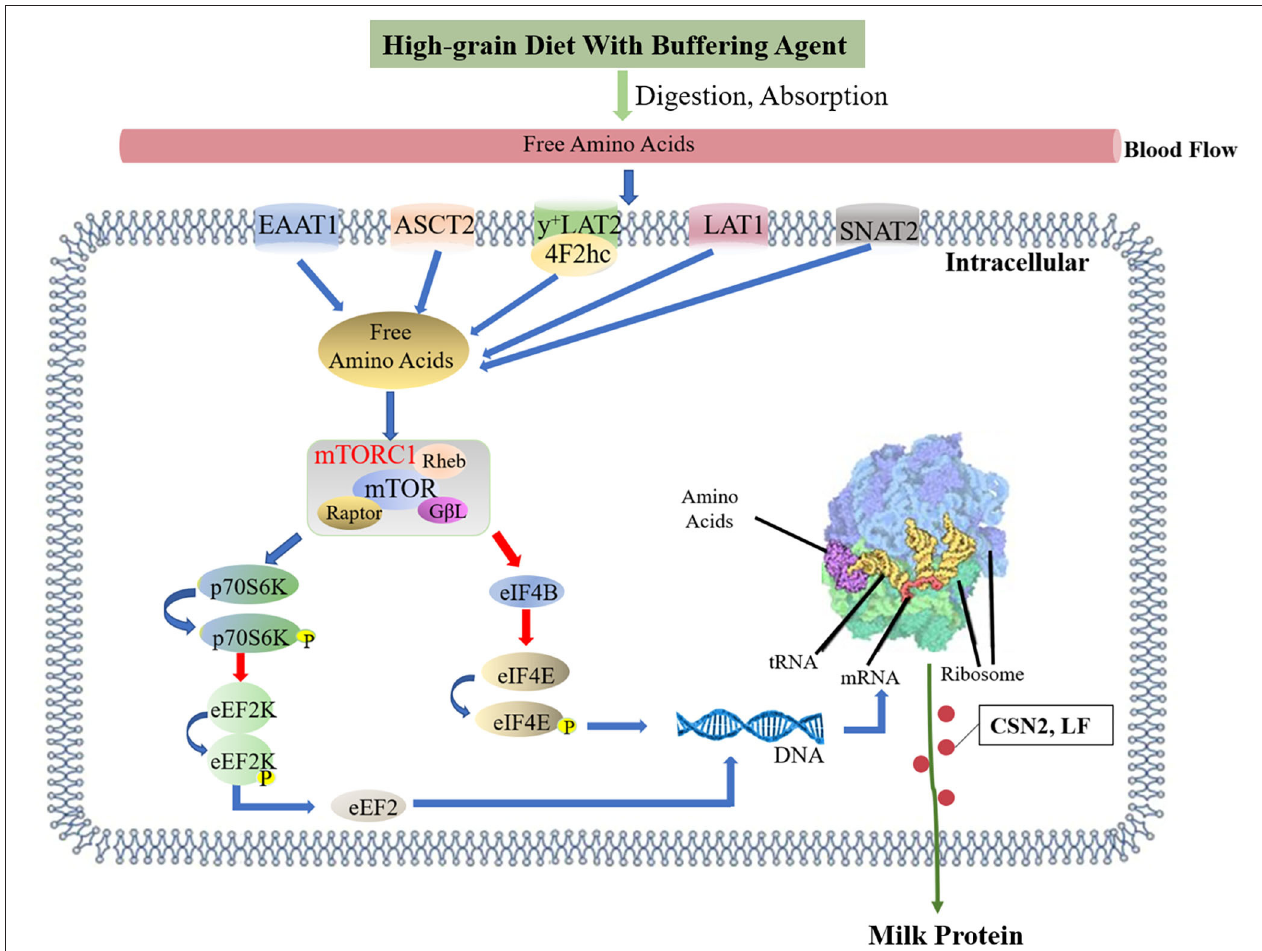
FIGURE 8 | Effects of high-grain diet with buffering agent on the milk protein synthesis. Feeding of high-grain diet with buffering agent promoted the jugular vein blood of amino acids concentration, and the mRNA expressions of amino acid transport SLC1A3, SLC1A5, SLC7A5, SLC7A6, and SLC38A2 in mammary tissues were up-regulated, it showed that more amino acids flowed into the mammary. Amino acids in mammary gland activated mTOR pathway. mTORC1 activates P70S6K via phosphorylation, which in turn activated several proteins that contributed to promote protein synthesis. In addition, activation of P70S6K inhibited eEF2K via phosphorylation, subsequently stimulated eEF2, which activated translocation elongation. When mTORC1 was phosphorylated, it inhibited 4EBP1 through phosphorylation, which inhibits eIF4E. eIF4E activates cap-dependent translocation increasing protein synthesis. The blue arrow represents promotion, and the red arrow represents